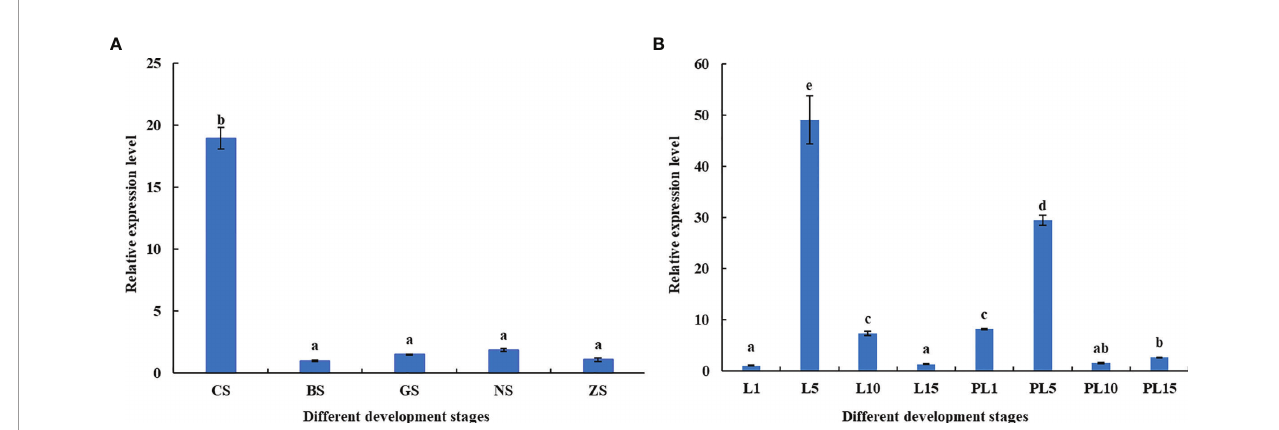
FIGURE 7 | Expression of the MnFtz-f1 Gene in Different Developmental Stages of Embryos (A) and Individuals (B) . CS, cleavage stage; BS, blastula stage; GS, gastrula stage; NS, nauplius stage; ZS, zoea stage; L1, the fi rst day after hatching; PL1, the fi rst day after larvae, and so on. Statistical analyses were performed by one-way ANOVA. Data are expressed as mean ± SEM (n = 6). Bars with different letters indicate signi fi cant differences ( P < 0.05).